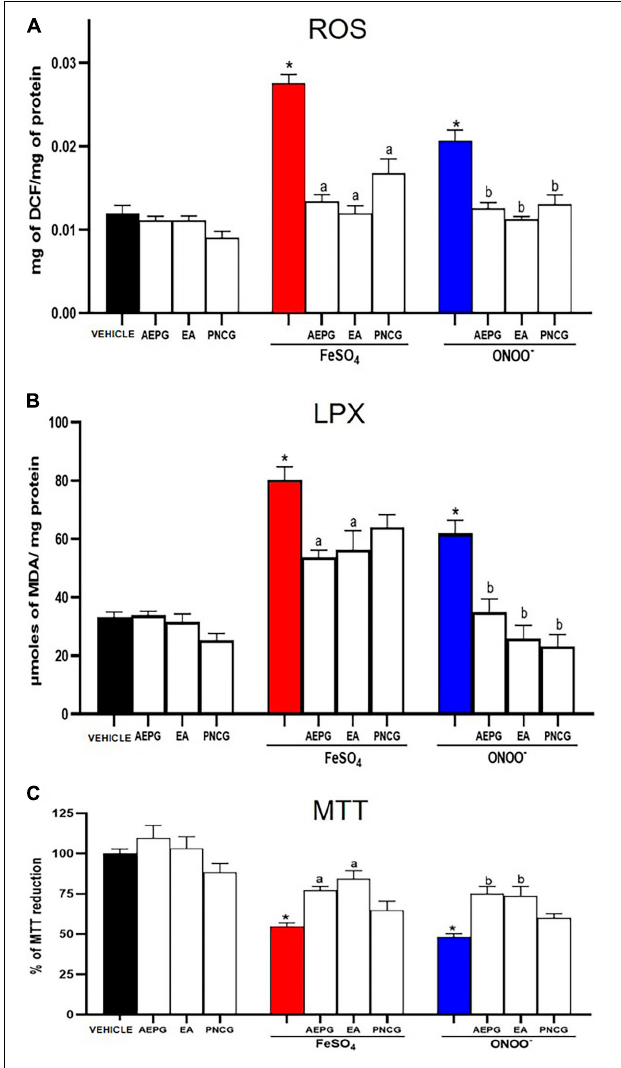
FIGURE 9 | Effect of AEPG, fractions with EA and PNCG on reactive oxygen species (ROS, panel A ), Lipid peroxidation (LPX, panel B ) production and cellular dysfunction (MTT, panel C ) induced by FeSO 4 (10 µ M), and peroxynitrite (ONOO − ; 50 µ M) in brain homogenates from ovariectomized rats. Data are shown as mean ± S.E.M. of seven experiments per group (each experiment corresponding to one rat). * p < 0.05 vs. control, a , b p < 0.05 versus respective vehicle treated group based on the Mann-Whitney test for each pro-oxidant. AEPG = aqueous extract of Punica granatum (1.0 mg/kg), EA = ellagic acid (0.01 mg/kg), PNCG = punicalagin (0.01